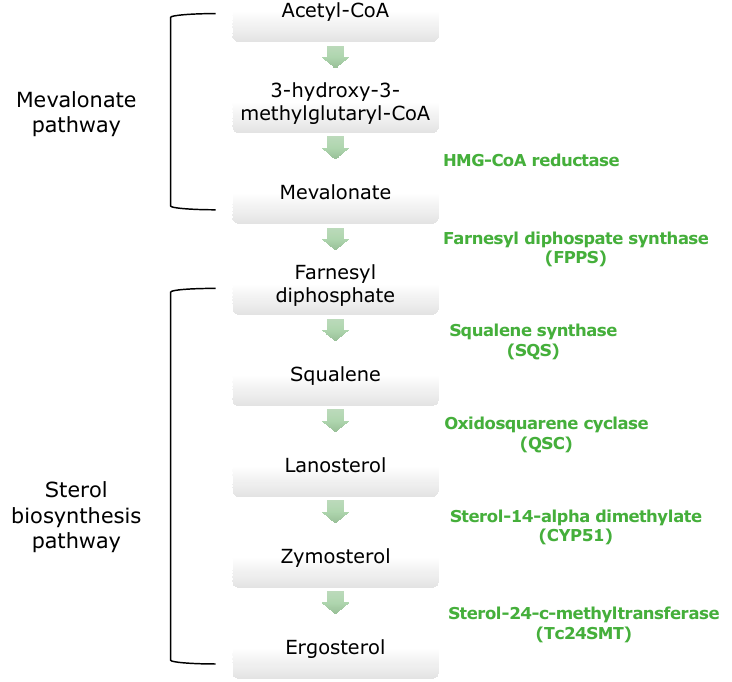
Figure 4. Ergosterol biosynthesis pathway.